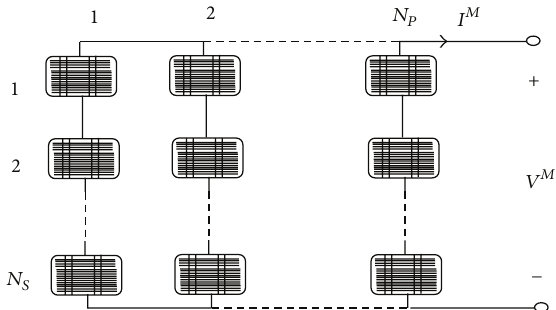
Figure 5: The equivalent circuit for a PV module.